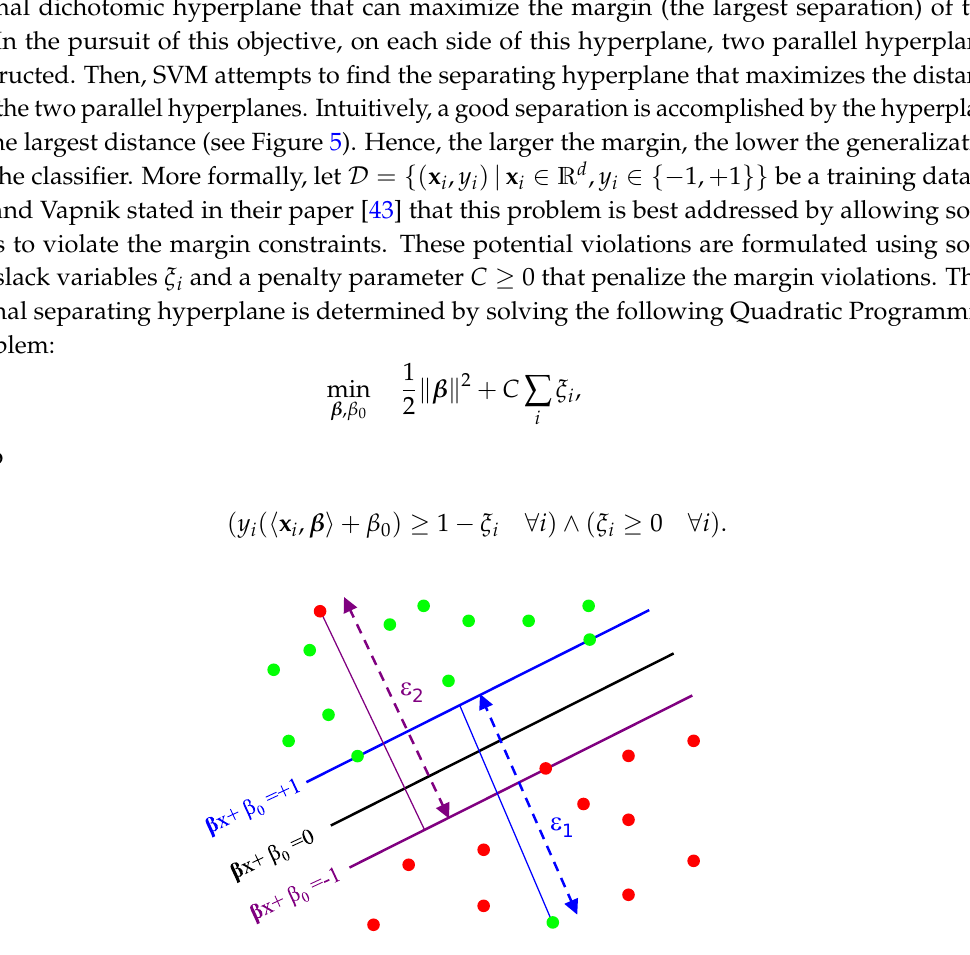
Figure 5. Generalized optimal separating